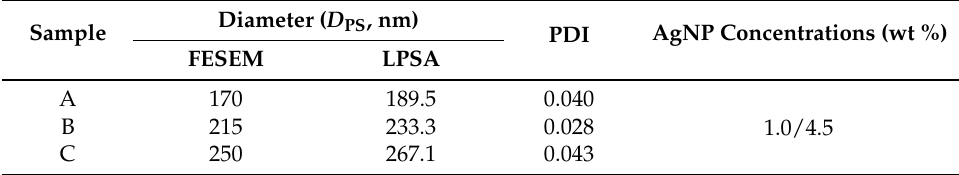
Table 1. Structural parameters for the three AgNPs/polystyrene (PS) hybrid colloidal photonic crystals (CPhCs) films.